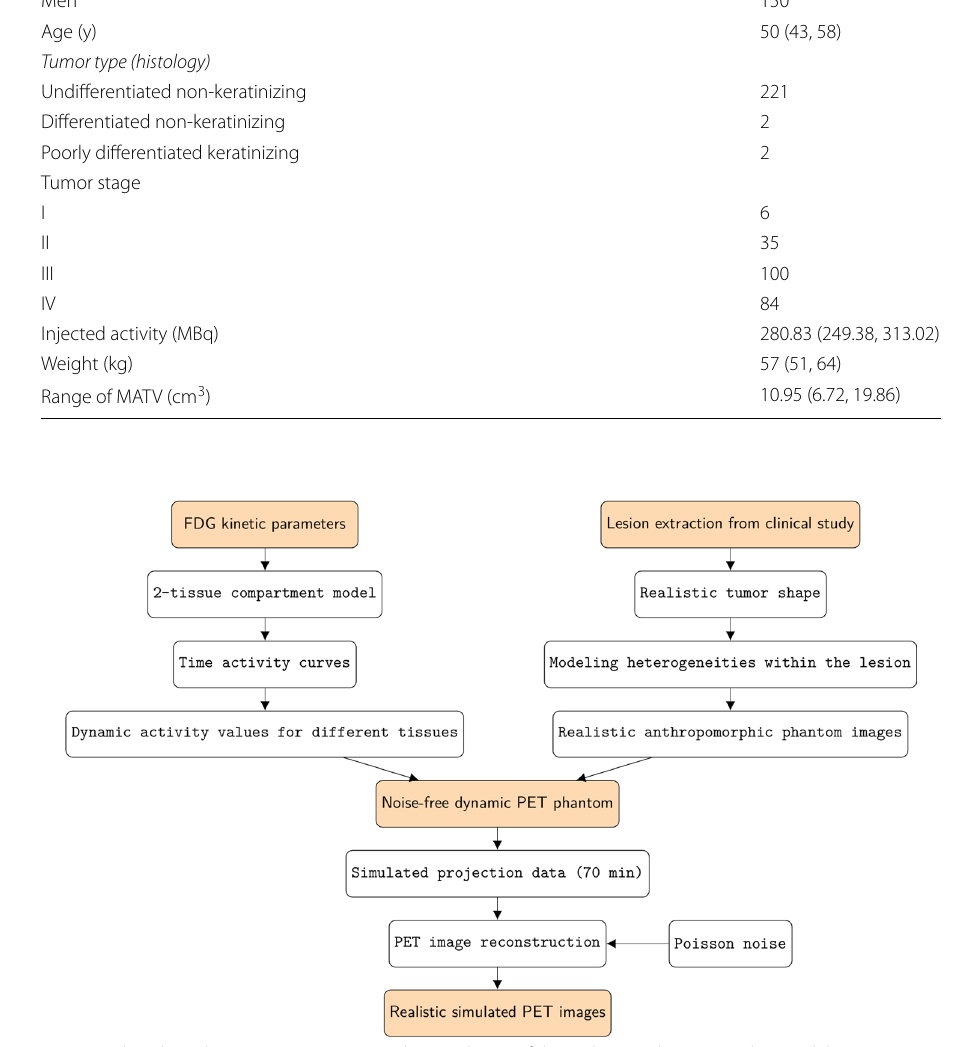
Fig. 1 Flowchart showing various steps in the simulation of the realistic anthropomorphic model